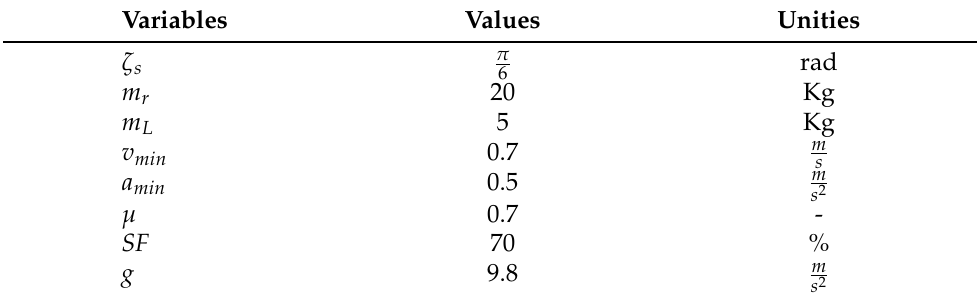
Table 2. Related parameters to design